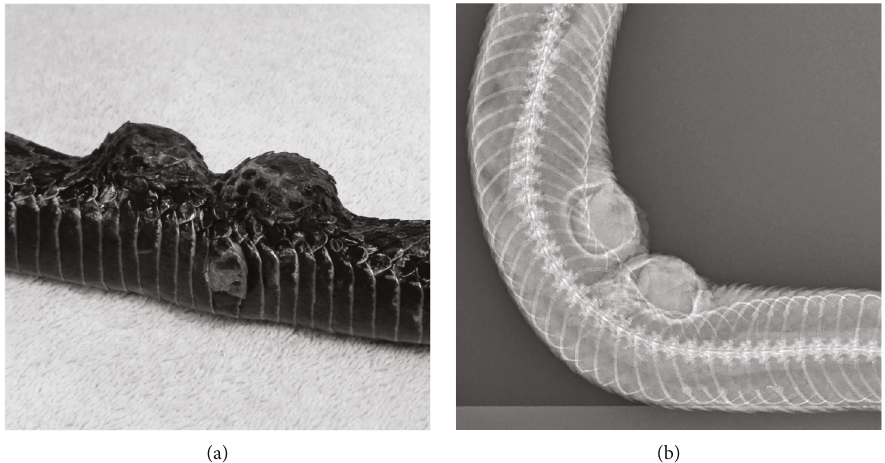
Figure 3: (a) Photograph and (b) dorsoventral radiograph of a Massasauga rattlesnake ( Sistrurus catenatus ) showing maximal expansion of two self-in fl ating hygroscopic tissue expanders four weeks after implant